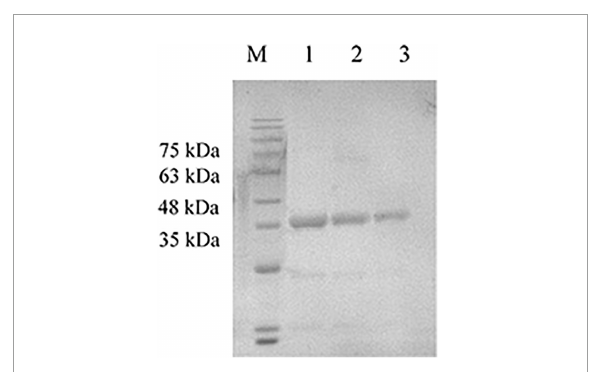
FIGURE2 Detection of the expression product GM-CSF by SDS-PAGE. The purified expression product GM-CSF was diluted with PBS and mixed with 4 × loading buffer to conduct SDS-PAGE. M: Solarbio 180 Marker, 1: GM-CSF (2,000 µ g/mL), 2: GM-CSF (1,000 µ g/mL), and 3: GM-CSF (500 µ g/mL).